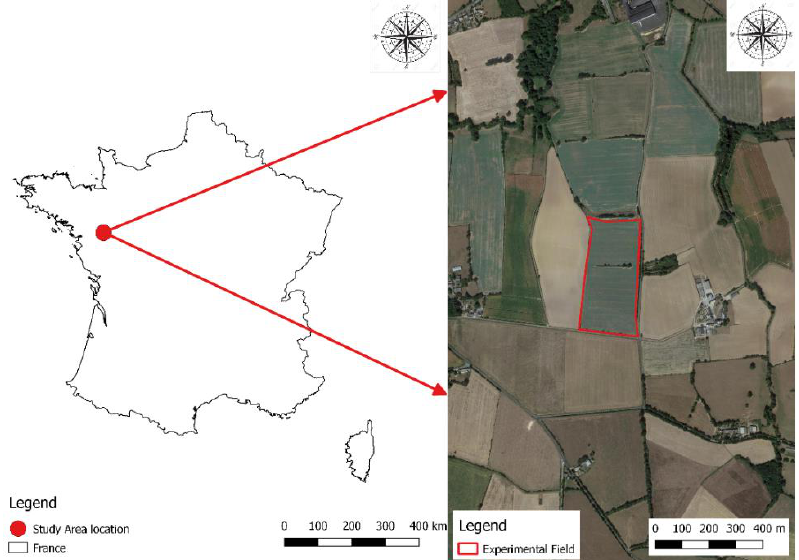
Figure 1. Study area location and field test.